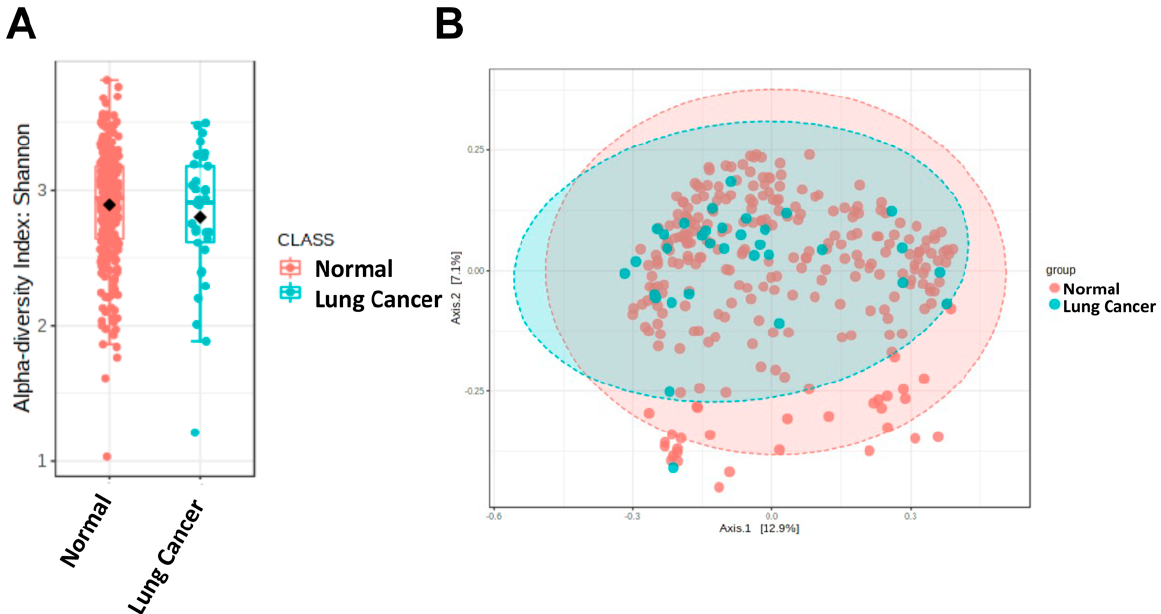
Figure 1. Gut dysbiosis in the patients with NSCLC. The alpha diversity in the NSCLC cases and healthy controls is illustrated using ( A ) Shannon diversity and ( B ) principal coordinates analysis (PCoA) derived from unweighted and weighted analysis of two populations ( p < 0.0001 by PER- MANOVA).